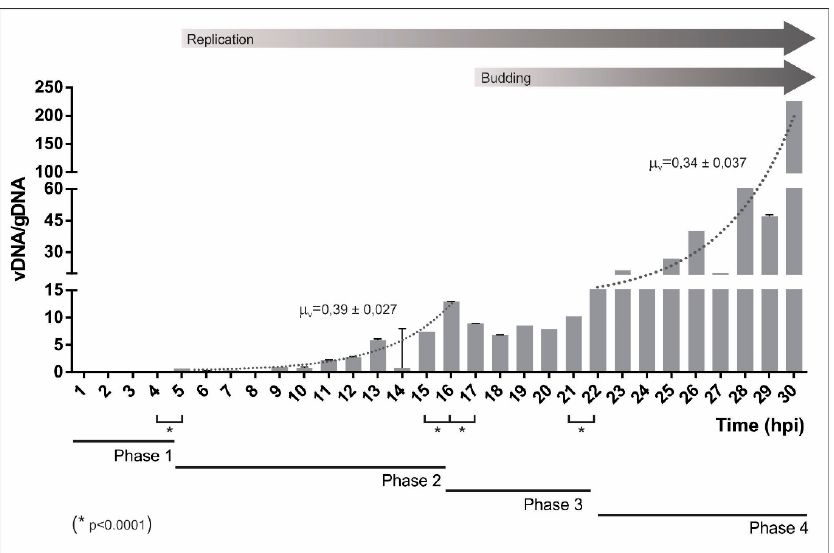
Figure 1. Replication kinetics of AgMNPV. Synchronized monolayers (70% confluence) of UFL-Ag-286 cells growing on 24 multiwell plates were exposed with AgMNPV (moi 10) for 1 hour. Then, cells were incubated with growth medium for 1 to 30 hours at 27 °C (hpi: hours post infection). DNA was recovered from the conditioned medium and cells by triplicate for each point. To quantify relative levels between cell and virus DNAs (gDNA and vDNA, respectively), qRT-PCR assays were applied. The results were plotted as quotients between vDNA and gDNA. The statistical error was calculated and then propagated to obtain the error bars. The beginning of replication and budding are indicated with grey arrows. Replication stages: Phase one, from 0 to 4 hours; phase two, from 5 to 16 hours; phase three, from 17 to 21 hours; and phase four, from 22 to at least 30 hours. The replication rates corresponding to phase two and four are indicated with a dotted line. An unpaired parametric t -test was done between the vDNA/gDNA values corresponding to contiguous times. The statistically significant differences (* p < 0.0001) that separate the replicative phases are indicated.